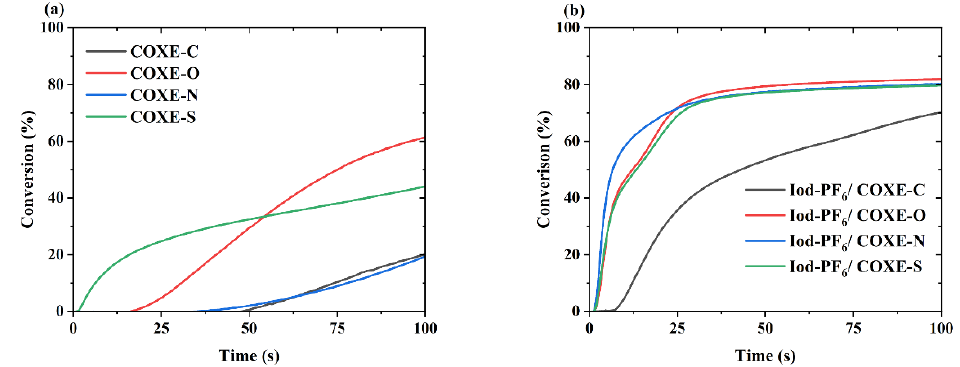
Figure 9. C=C double bond conversion curves obtained for TPGDA polymerization initiated by COXEs (2.4 × 10 − 6 mol · g − 1 ) ( a ) without Iod-PF 6 and ( b ) with Iod-PF 6 (1.2 × 10 − 5 mol · g − 1 ) under 400 nm LED irradiation (photo intensity: 100 mW · cm − 2 ) for 100 s.